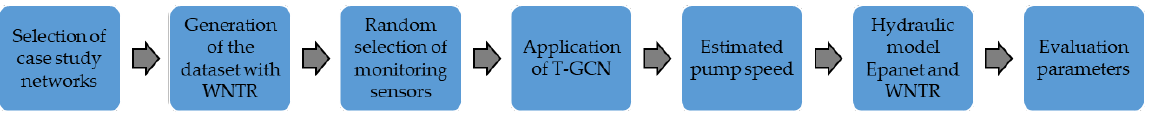
Figure 1. General diagram of the developed procedure.